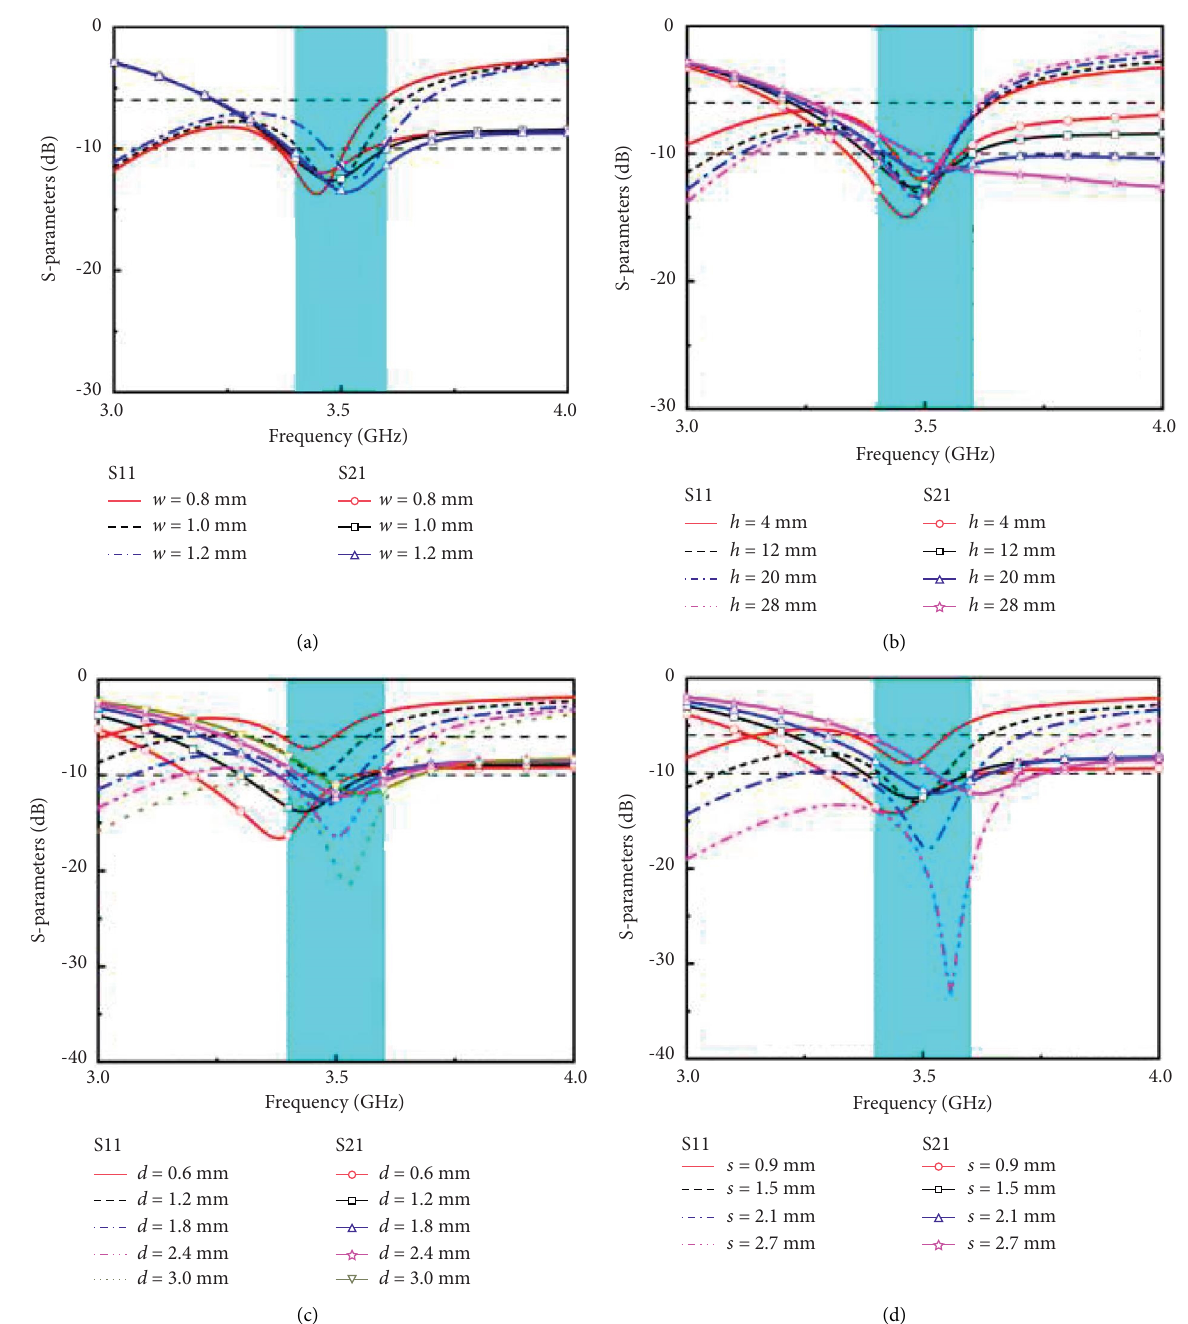
Figure 3: Simulated S-parameters of the dual-port microstrip antenna pair with diferent values of (a) w . (b) h . (c) d . (d) s